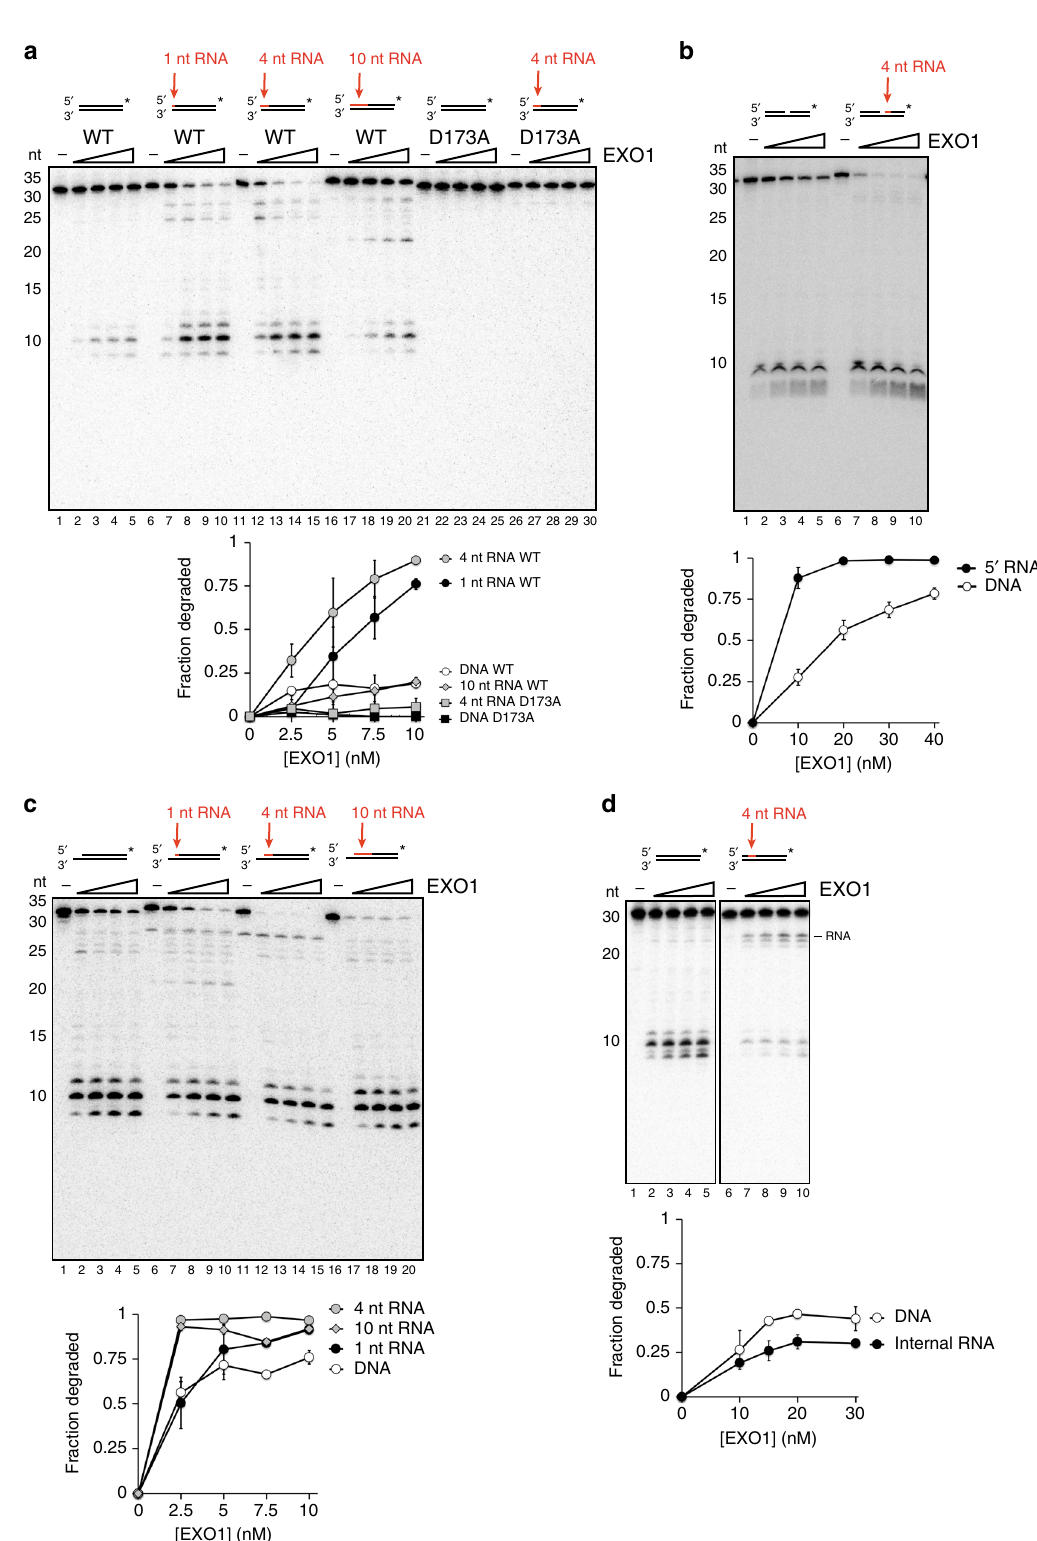
Fig. 1 Effect of ribonucleotides on EXO1 activity. a EXO1 (2.5, 5, 7.5 10 nM) or the nuclease-de fi cient EXO1-D173A mutant was incubated with the indicated 30-mer substrate (2.5 nM) at 37 °C for 10 min. Products were resolved in a 20% denaturing polyacrylamide gel. b Nicked substrates with or without a 4-nt RNA tract were tested as in ( a ). These substrates consisted of two 35-mers annealed to a 70-mer to create the central nick. c The indicated substrates with a 5-nt 3 ′ overhang were tested as in ( a ). d The indicated substrates with a 4-nt RNA tract located 4 nt internally from the 5 ′ end were tested as in ( a ). Error bars in all the panels represent the standard deviation of results from n = 3 independent experiments, and all points represent the mean. RNA is denoted in red, and the asterisk indicates the location of the